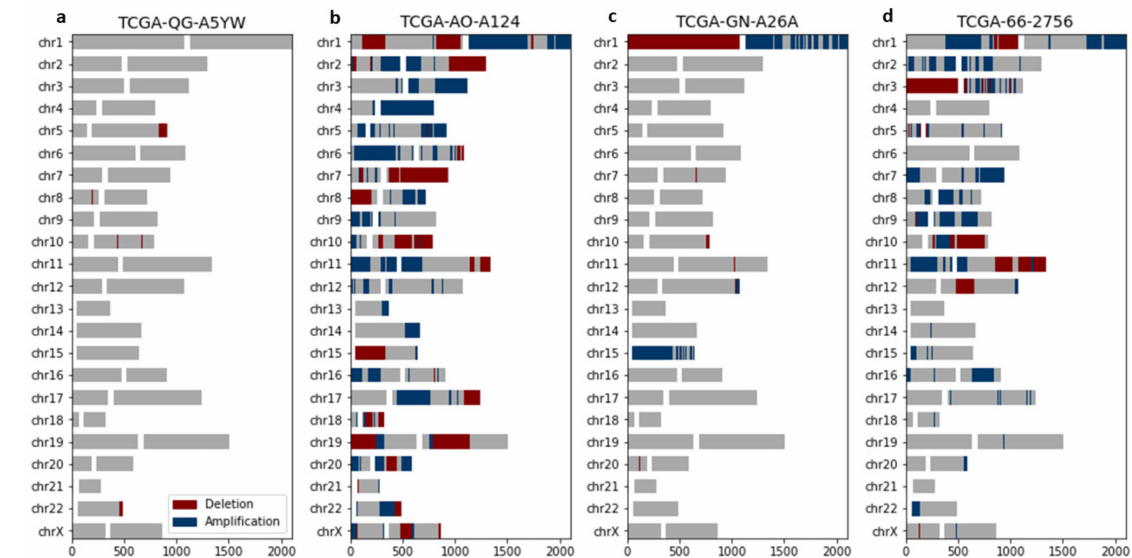
Figure 3. Chromoanagenesis samples present chromosome-specific CNA oscillations. CNA patterns for four representative PCAWG–TCGA samples. For each chromosome, gene amplification and gene deletion are depicted by blue and red, respectively. Centromeres are signified by a white gap, separating the p -arm (left) from the q-arm (right). ( a ) TCGA-QG- A5YW, a COAD patient without chromoanagenesis with a total of 7 oscillations. ( b ) TCGA-AO-A124, a BRCA patient without chromoanagenesis with a total of 118 oscillations. ( c ) TCGA-GN-A26A, a SKCM patient with chromoanagenesis with a total of 35 oscillations (primarily in chromosomes 1 and 15). ( d ) TCGA-66-2756, a LUSC patient with chromoanagenesis with a total of 122 oscillations (primarily in chromosome 3).